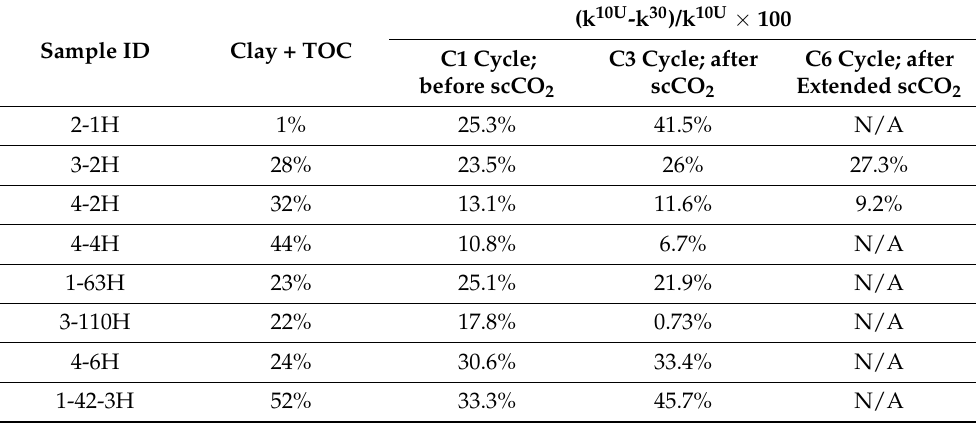
Table 3. Pressure dependency rates of argon permeabilities (C1, C3, and C6 cycles in the tests), before and after interaction with scCO 2 .